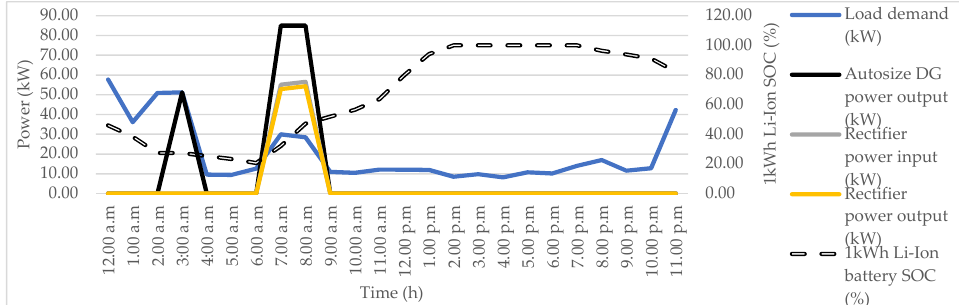
Figure 15. Rectifier operation for the month of June.